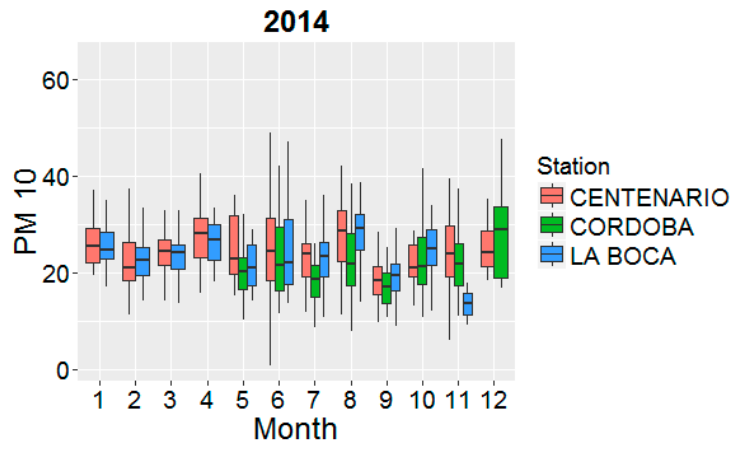
Figure 6. Monthly PM 10 mean for 2014 at three different air quality stations at Buenos Aires City (Centenario, Cordoba and La Boca). Median is indicated with a line inside the box. The lower and upper hinges correspond to the first and third quartiles (the 25th and 75th percentiles). The whiskers extends from the hinge to the largest value no further than ±1.5 * IQR (the inter-quartile range, or distance between the first and third quartiles) from the hinge.